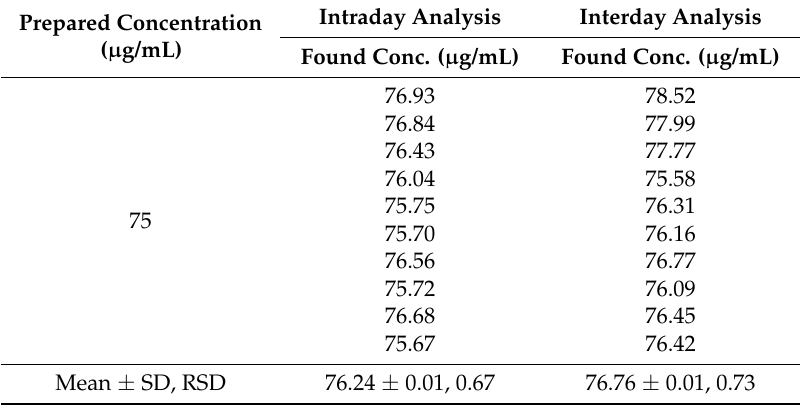
Table 1. Intra and Interday precision data of the analytical method for vanillyl butyl ether based